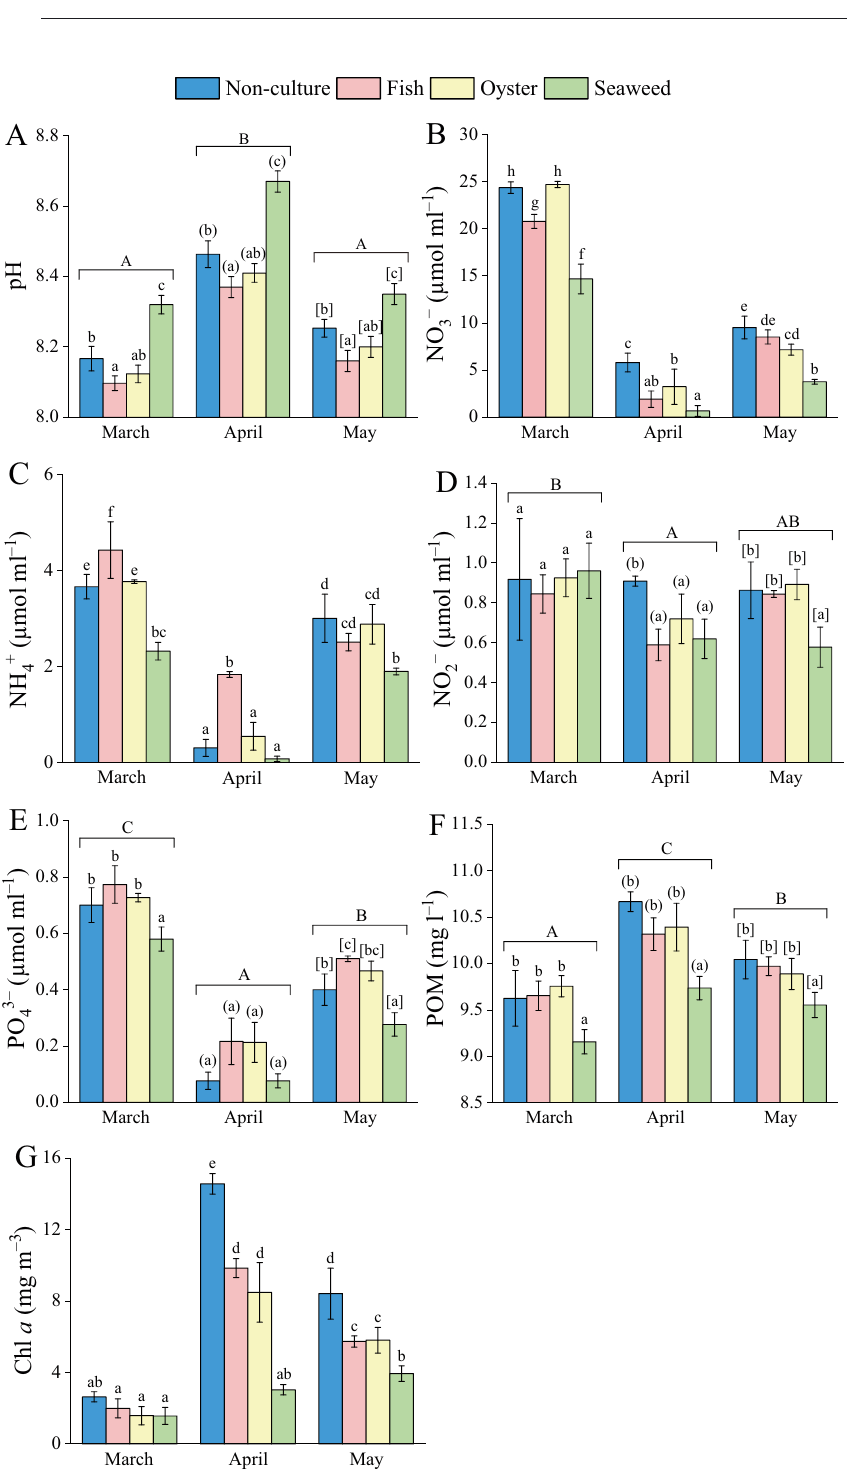
Fig. 3. (A) pH and concentrations of (B) nitrate (NO 3− ), (C) ammonium (NH 4+ ), (D) ni- trite (NO 2 − ), (E) phosphate (PO 4 3− ), (F) particulate organic matter (POM) and (G) chl a in different culture areas of Shen’ao Bay from March to May 2016. For pH, NO 2− , PO 43− and POM, different lowercase letters without, in round and in square brackets above the columns represent statistically different results in March, April and May, respectively. Different uppercase letters above the columns represent statistically different results among areas in March, April and May. For NO 3− , NH 4+ and chl a , different lowercase letters above the columns represent statistically different results among areas and months. Error bars show